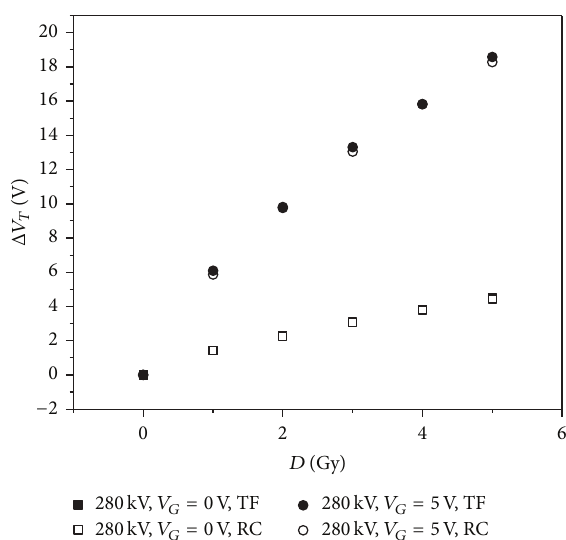
Figure 3: Extrapolated (TF) and reader circuit (RC) Δ𝑉 𝑇 during 200 kV X-ray irradiation with zero and +5V gate bias.